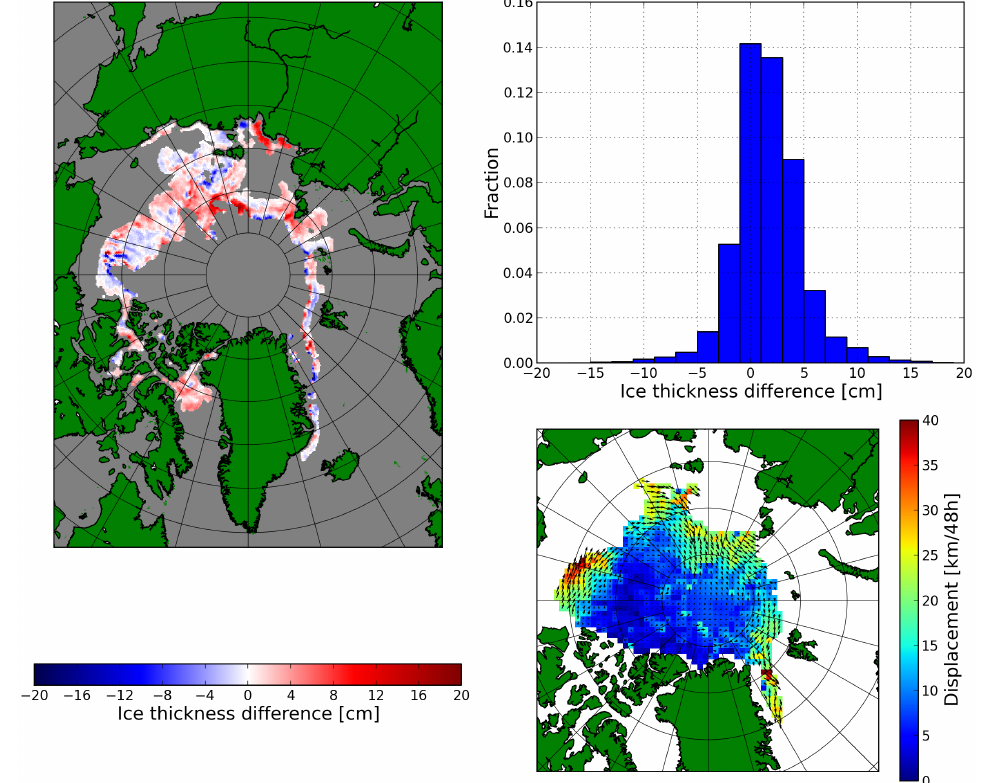
Fig. 10. Difference map of SMOS SIT retrieval from 20 to 21 October 2011 in the ice growth phase (left). Areas of open water and areas where the retrieval’s 50+cm flag is set are excluded. Histogram of day-to-day change from 20 to 21 October 2011 (top right). OSISAF sea ice displacement product from 19 to 21 October 2011 (bottom right).